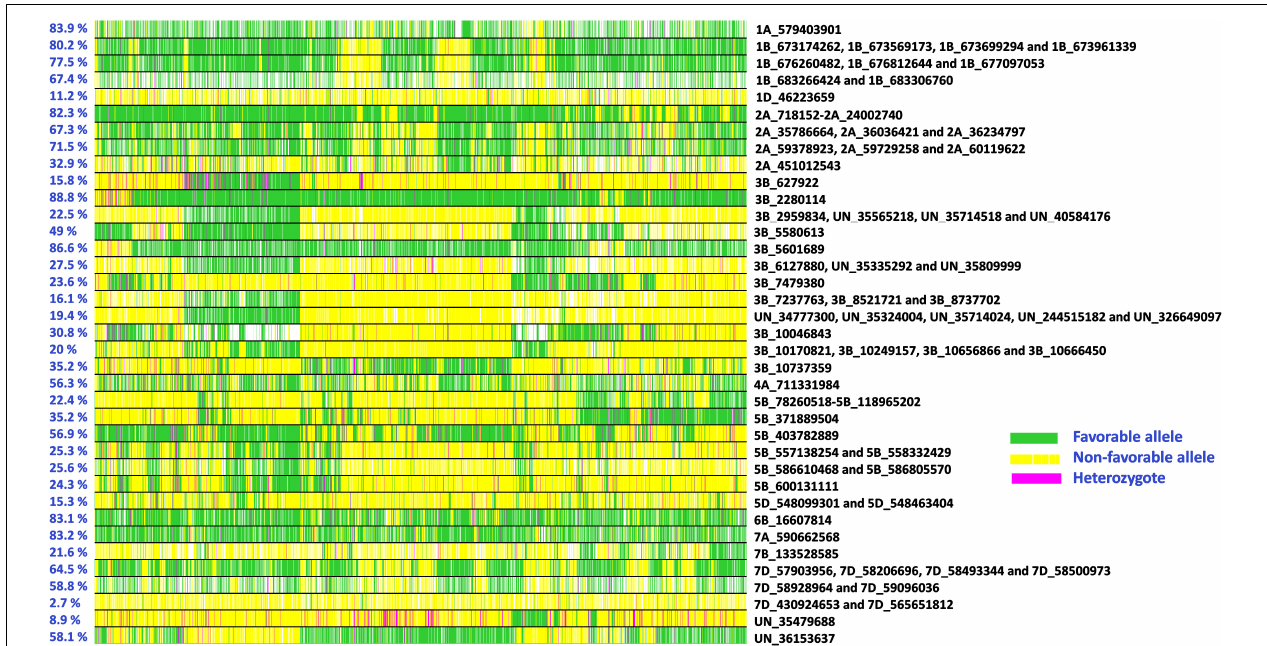
FIGURE 5 | Allelic fingerprinting of spot blotch associated markers. The percentage values on the left indicate the percentage of lines with favorable alleles at the markers. The green color indicates the favorable allele (allele that has a decreasing effect on spot blotch), the yellow color indicates the non-favorable allele (allele that has an increasing effect on spot blotch), the magenta color indicates the heterozygote, and the white color indicates missing data.